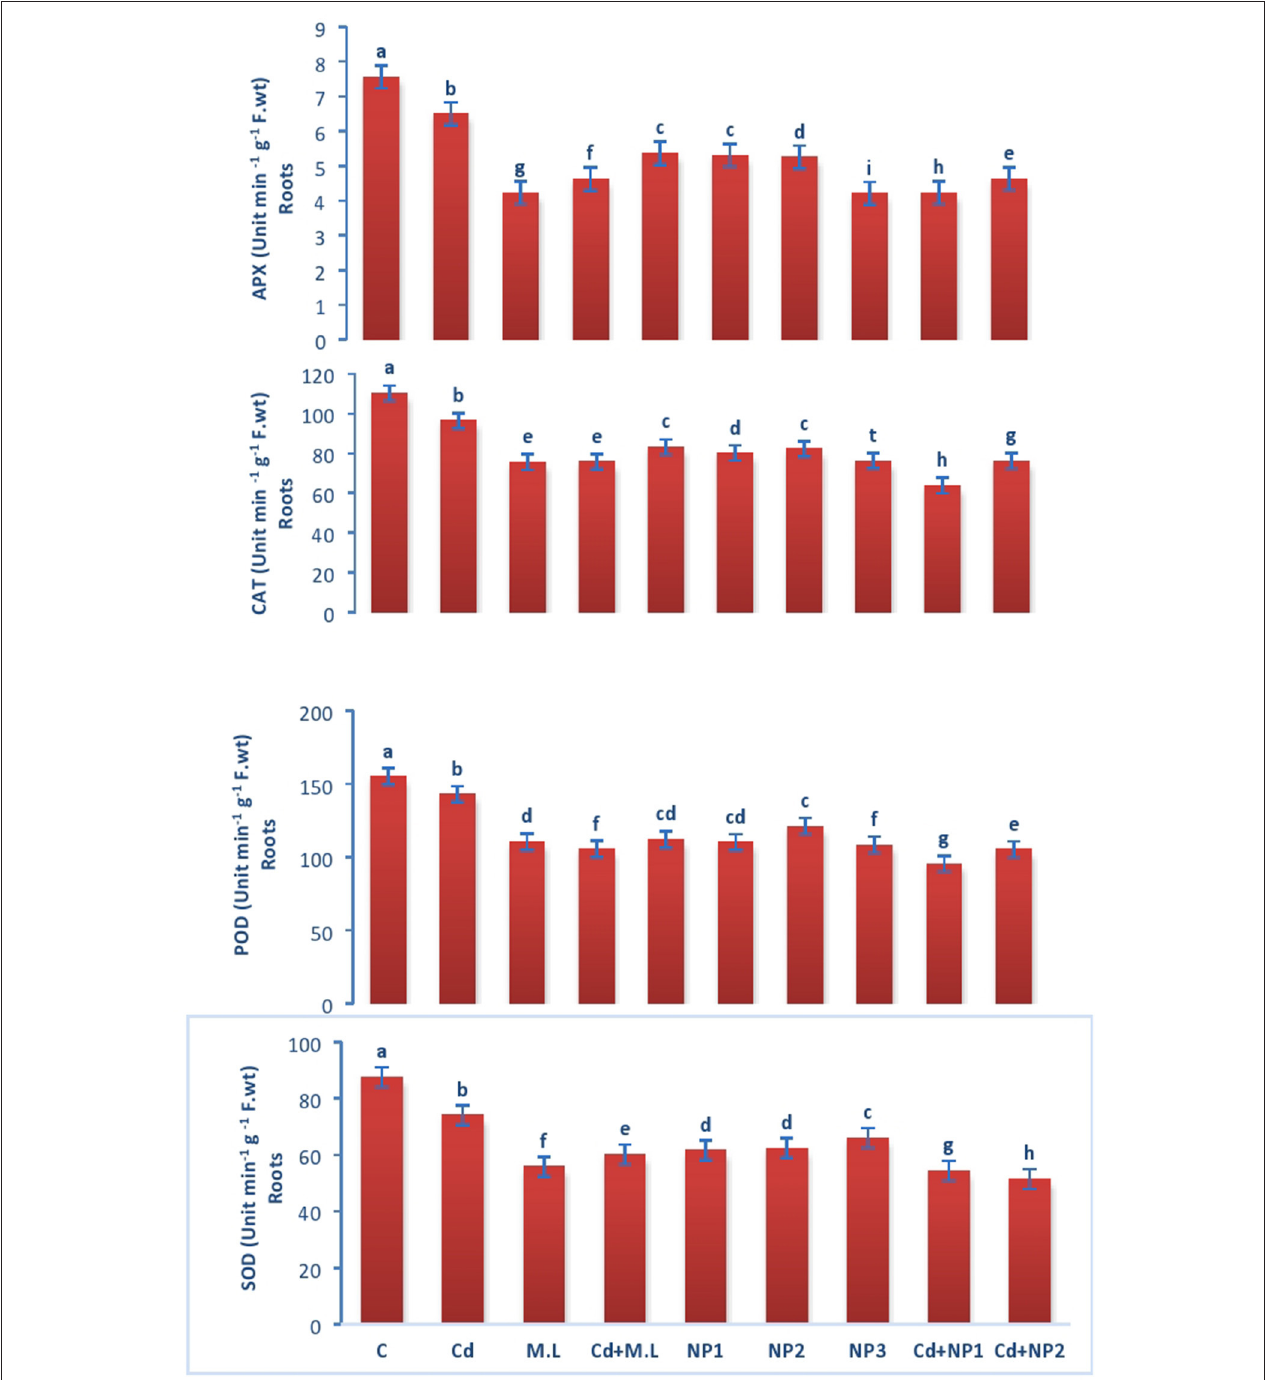
FIGURE 5 | Effects of MZnO–NPs on APX, CAT, POD, and SOD under Cd stress in Linseed roots. Different letters indicate significant difference between the treatments. Data are means ± SE ( n = 5). Non-identical letters specify significant difference at P ≤ 0.05. C, Control, Cd, 100mg kg − 1 Cd, M. L, Moringa oleifera leaves; NP1, 100mg L − 1 MZnO-NPs; NP2, 500mg L − 1 MZnO-NPs; NP3, 1g L − 1 MZnO-NPs.